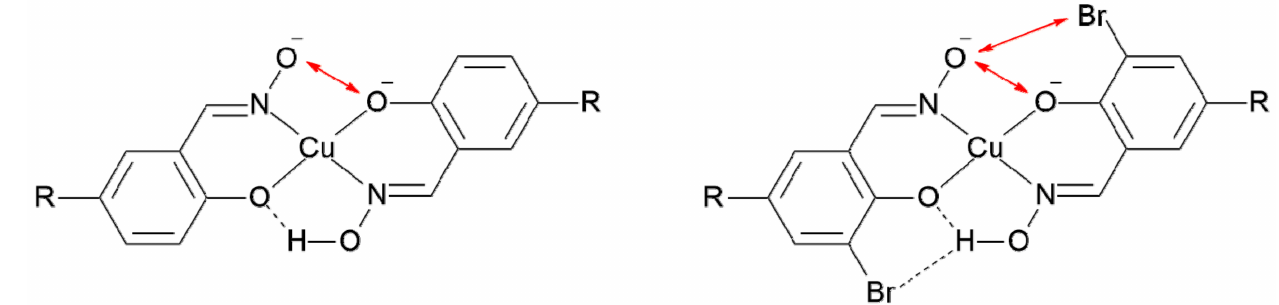
Figure 8. A representation of the origins of the stabilization of the monoanions [Cu( L )( L H)] − by H-bonding in the lower part of the complexes (—) and of the destabilization by repulsion between electronegative atoms (double-headed red arrows in the upper part of the complexes). An MeCN solution containing a 2:1:1 molar ratio of copper(II) acetate and L 6 H 2 and its 3-bromosubstituted derivative L 8 H 2 gave an ESI-MS spectrum containing four trinu- clear complexes: [Cu 3 O( L 6 ) 3 ] − , [Cu 3 O( L 6 ) 2 ( L 8 )] − , [Cu 3 O( L 6 )( L 8 ) 2 ] − , and [Cu 3 O( L 8 ) 3 ] − (Figure 9). The relative intensities of these (0.9:1:0.4:0.02) in comparison to a homoge- nous statistical distribution (1:3:3:1) will depend on to what extent the presence of the bromine atom influences their relative stabilities and their intensities will also depend on their stabilities relative to the mononuclear complexes [Cu( L 6 ) ( L 6 H)] − , [Cu( L 6 ) ( L 8 H)] − , [Cu( L 6 H ) ( L 8 )] − , and [Cu( L 8 ) ( L 8 )] − (the weak peaks clustered at m/z values at 447, 526, 526, and 605, respectively) which are formed on ionization of the neutral complexes [Cu( L H) 2 ]. The stabilities of the monoanions are influenced by H-bonding and electrostatic repulsion as shown in Figure 8. The presence of the 3-bromo substituent buttresses the interligand H-bonding when the oxime OH group is present [45] but enhances repulsion between the ligands when the oxime proton is lost.t